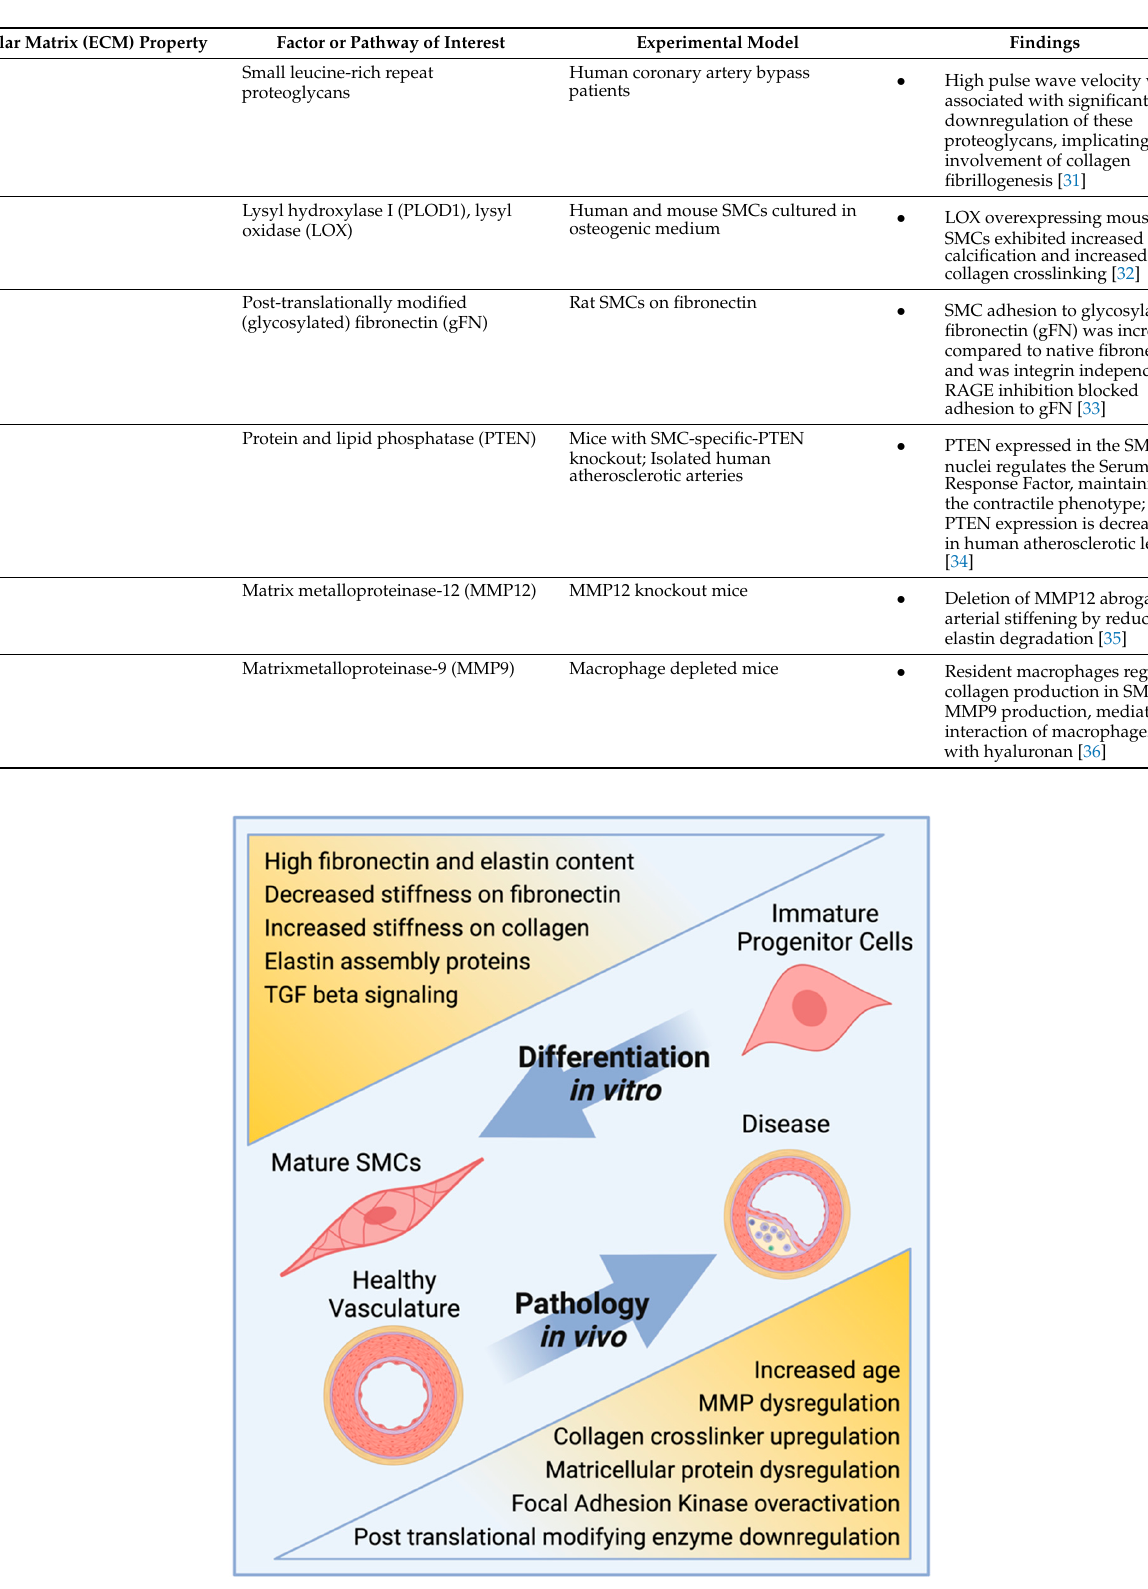
Figure 1. Schematic illustration of factors that prompt SMC maturation in culture systems (top) or disease progression in animal models (bottom). Created with BioRender.com. Table 1. Summary of recent studies covering ECM factors involved in SMC behavior regulation.